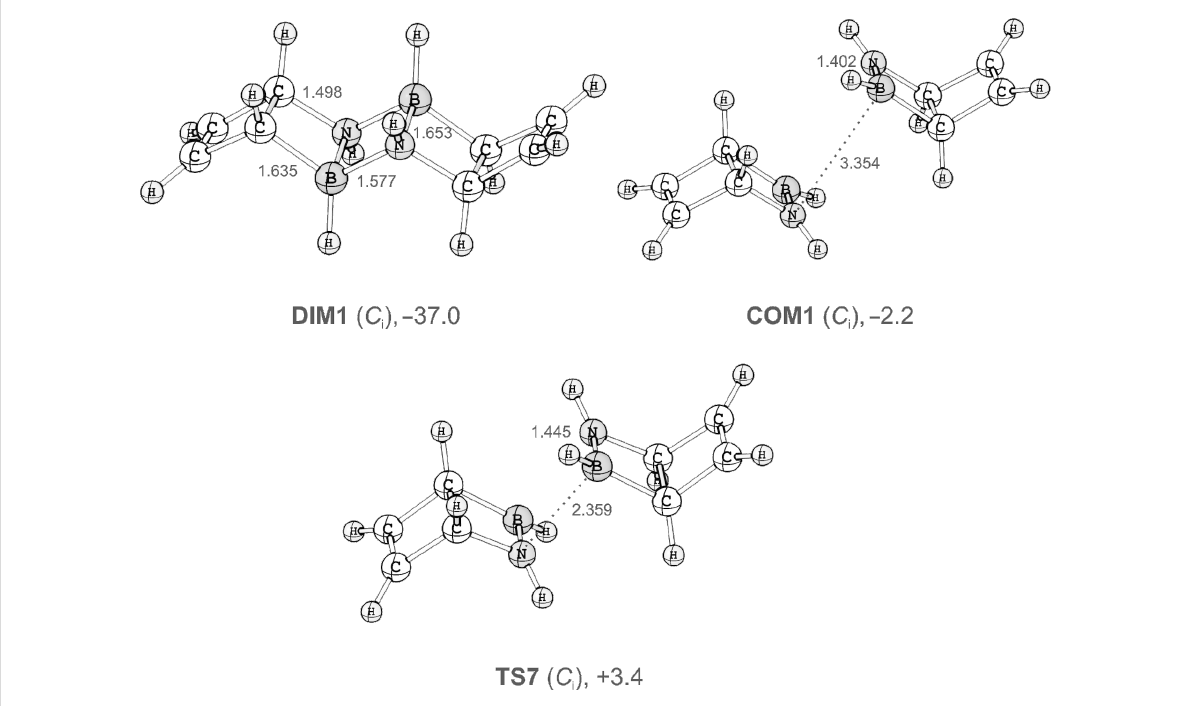
Figure 4: Geometries of DIM1 , COM1 , and TS7 computed at the SCS-RIMP2/def2-TZVP level of theory. Distances are given in angstroms (Å). Ener- gies (in kcal mol − 1 ) relative to two separated molecules of 3 were obtained at the same level of theory and include ZPVE corrections obtained with the smaller def-SV(P) basis